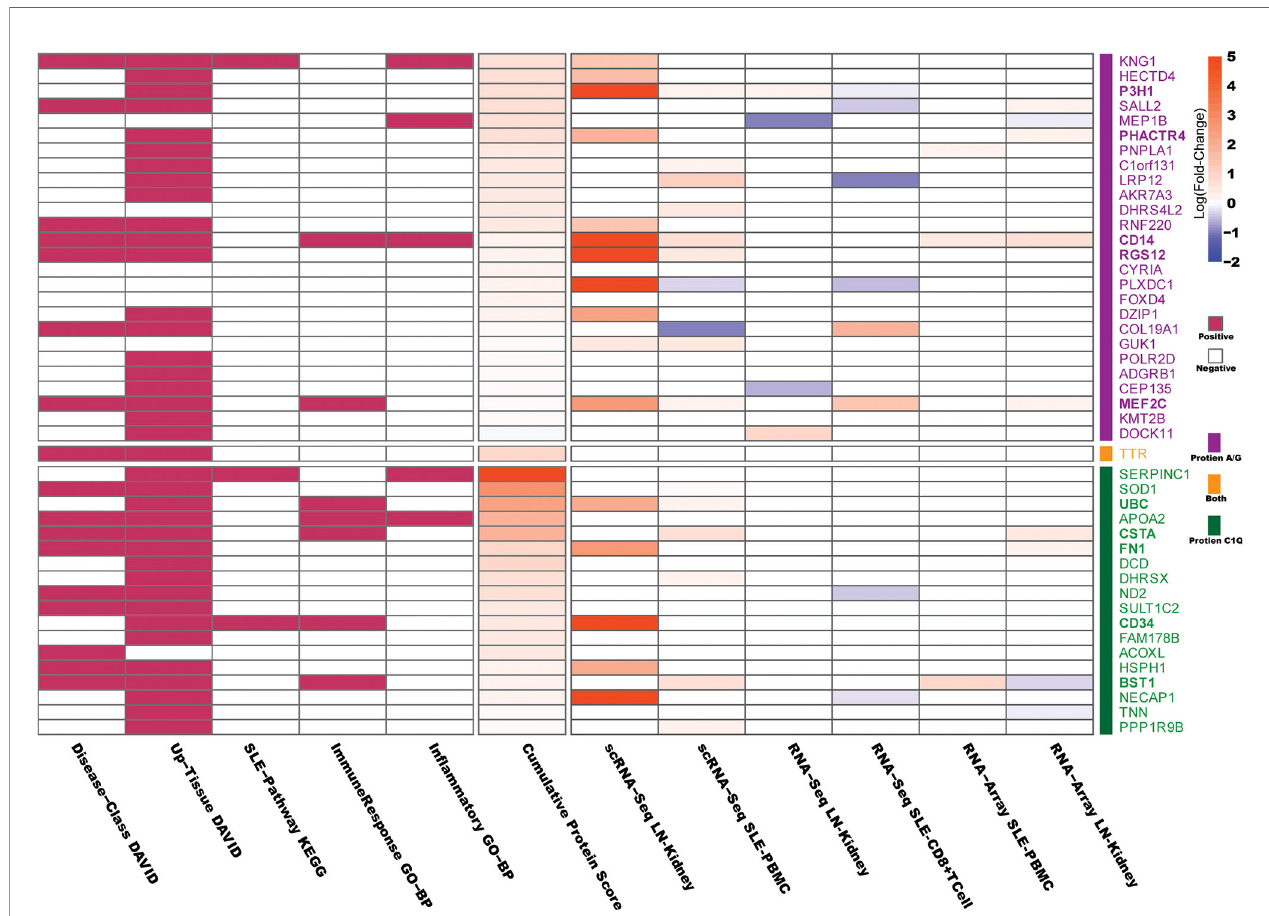
FIGURE 3 | Bioinformatics analysis of the protein candidates. The Database for Annotation, Visualization and Integrated Discovery (DAVID), Kyoto Encyclopedia of Genes and Genomes (KEGG), and Gene Ontology Biological Processes (GO-BP) were used to determine the relevance of the differentially expressed protein candidates to SLE or LN. In DAVID analysis, “ renal ” or “ immune ” disease-related proteins or the proteins expressed in SLE-affected tissues (such as skin, muscle, bone, joints, kidney, spleen and brain) were considered “ positive. ” In KEGG analysis, proteins involved in the “ Systemic lupus erythematosus - Homo sapiens (human) ” KEGG pathway and its eight related pathways were considered “ positive. ” In GO-BP analysis, “ immune response ” and “ In fl ammatory ” annotated proteins were considered “ positive. ” The “ Cumulative Protein Score ” is the sum of the peptide scores for each protein identi fi ed in LN, which were then normalized to be in the range of 0~5. The Differentially Expressed Genes (DEGs) corresponding to the 45 candidate autoantigens that appeared in six published SLE/LN databases are indicated in the right-hand column of the heatmap, where the fi lled color represents the log (fold-change) values (p.adjust < 0.05) as indicated in the scale bar. The details of the six databases are presented in Supplementary Table 3